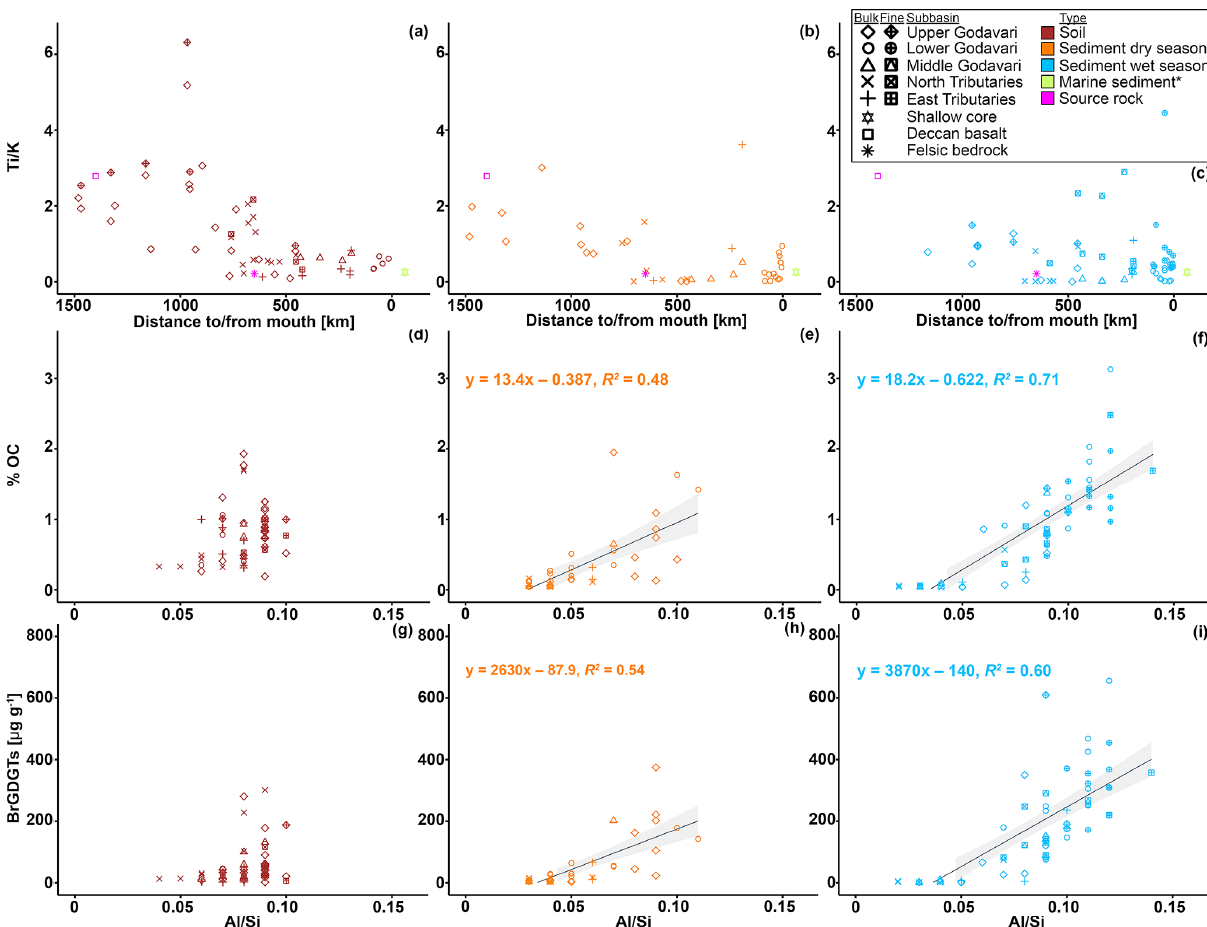
Figure 8. Ti / K ratios in (a) soils and riverbed sediments collected in the (b) dry and (c) wet season versus distance to/from the river mouth. The square and star (magenta) represent the endmember values for the Deccan basalts (Das and Krishnaswami, 2007) and felsic bedrock types (Archean Proterozoic gneiss complexes, APGC) (Moyen et al., 2003), respectively. The outlined star (green yellow) represents the average of marine sediments retrieved from ∗ shallow cores in front of the Godavari mouth (0–48cmb.s.f., ∼ 300 years; Kalesha et al., 1980) (error bars representing the standard deviation ( ± 0.02) are not visible as they are smaller than the symbol). The %OC and brGDGT concentrations versus Al / Si ratios in soils (d, g) and riverbed sediments collected in the (e, h) dry and (f, i) wet season, respectively. Low Al / Si ratios indicate a bulk mineralogical composition with high proportions of quartz (coarse grained), and high ratios indicate high proportions of micas and clays (fine grained) (Galy et al., 2008, 2010). Linear correlations (solid line) and 95% confidence intervals (grey shading) are shown. The symbols refer to the different subbasins and the different fractions (bulk and fine fractions ≤ 63µm). The colours refer to the different sample